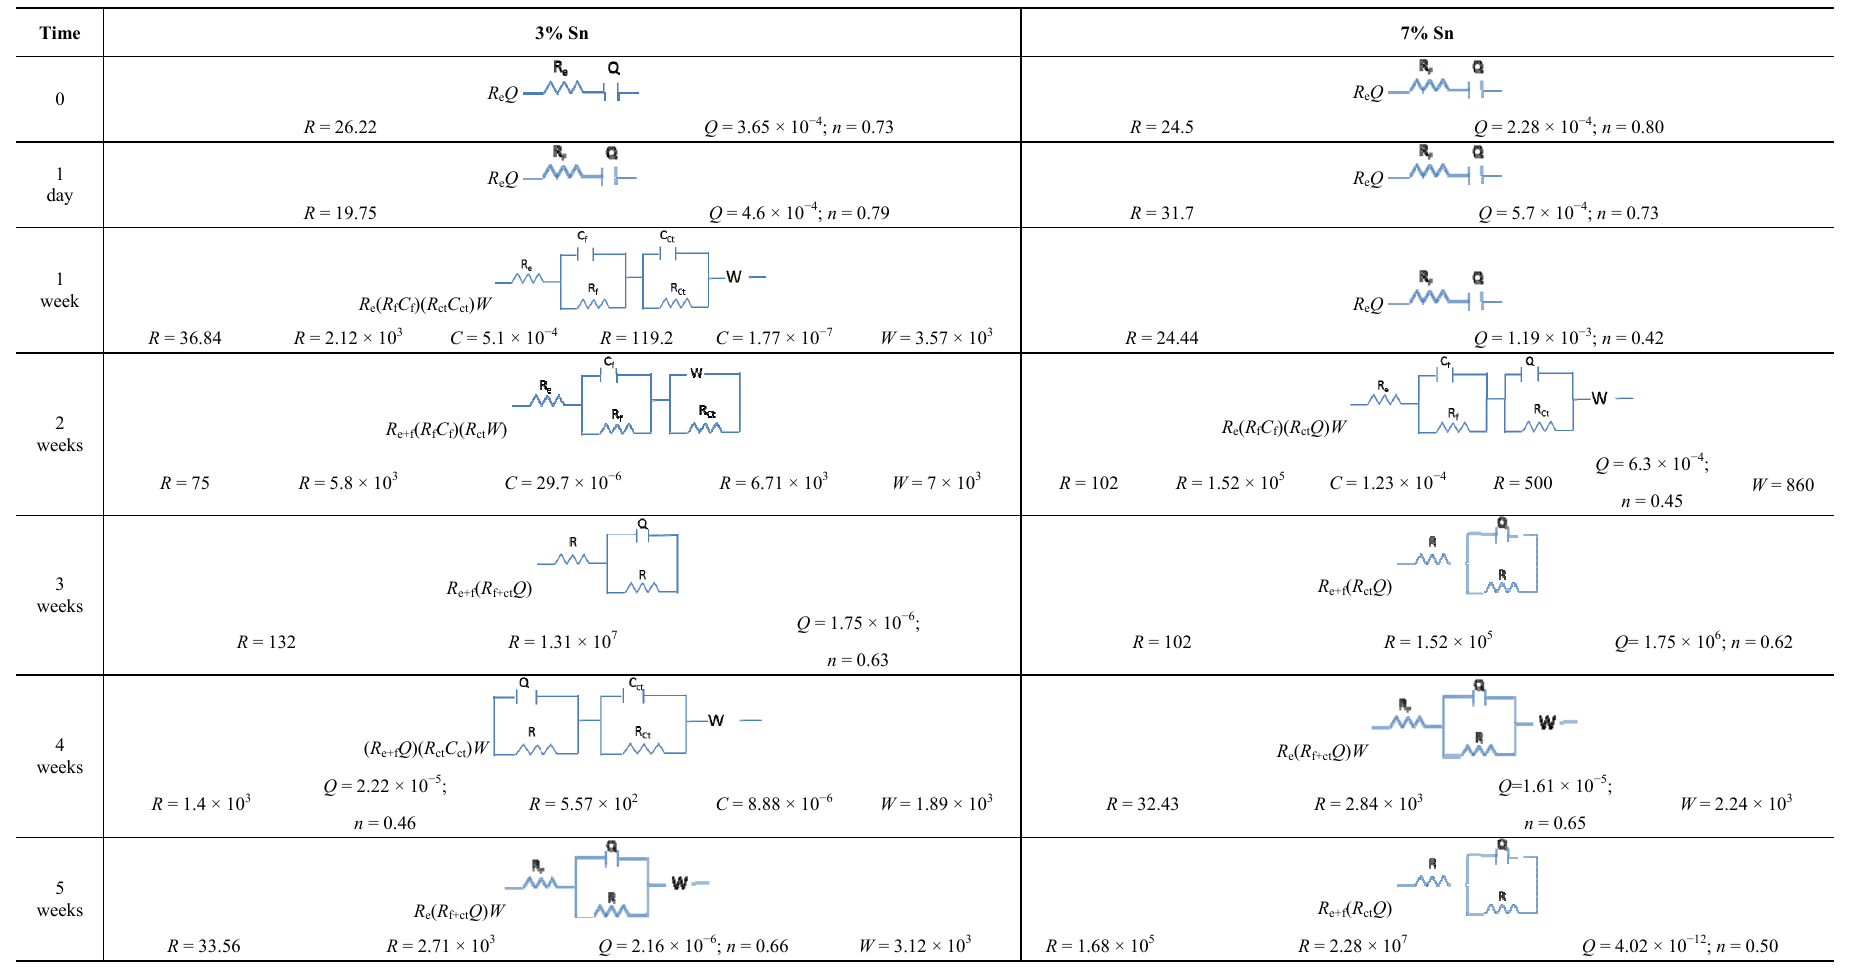
); the film f ); the Warburg ( W ); the constant e